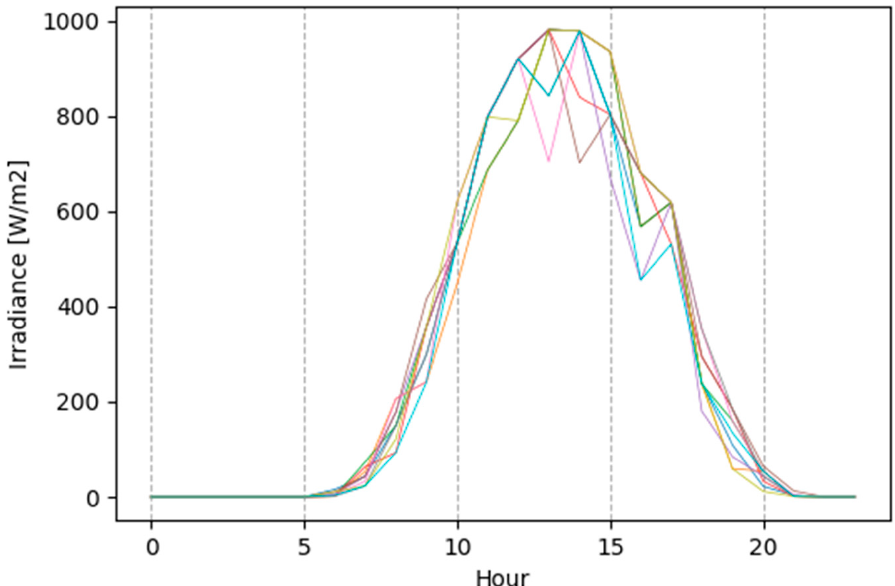
Figure 13. Ten generated scenarios reduced from one thousand initial scenarios using Fast-Forward algorithm with 7 regions, (cid:96) 2 -Norm metric, and without outlier removal. The historical data are related to July for the city of Turin (Italy) from 2005 to 2016. Different line colors represent different scenarios.